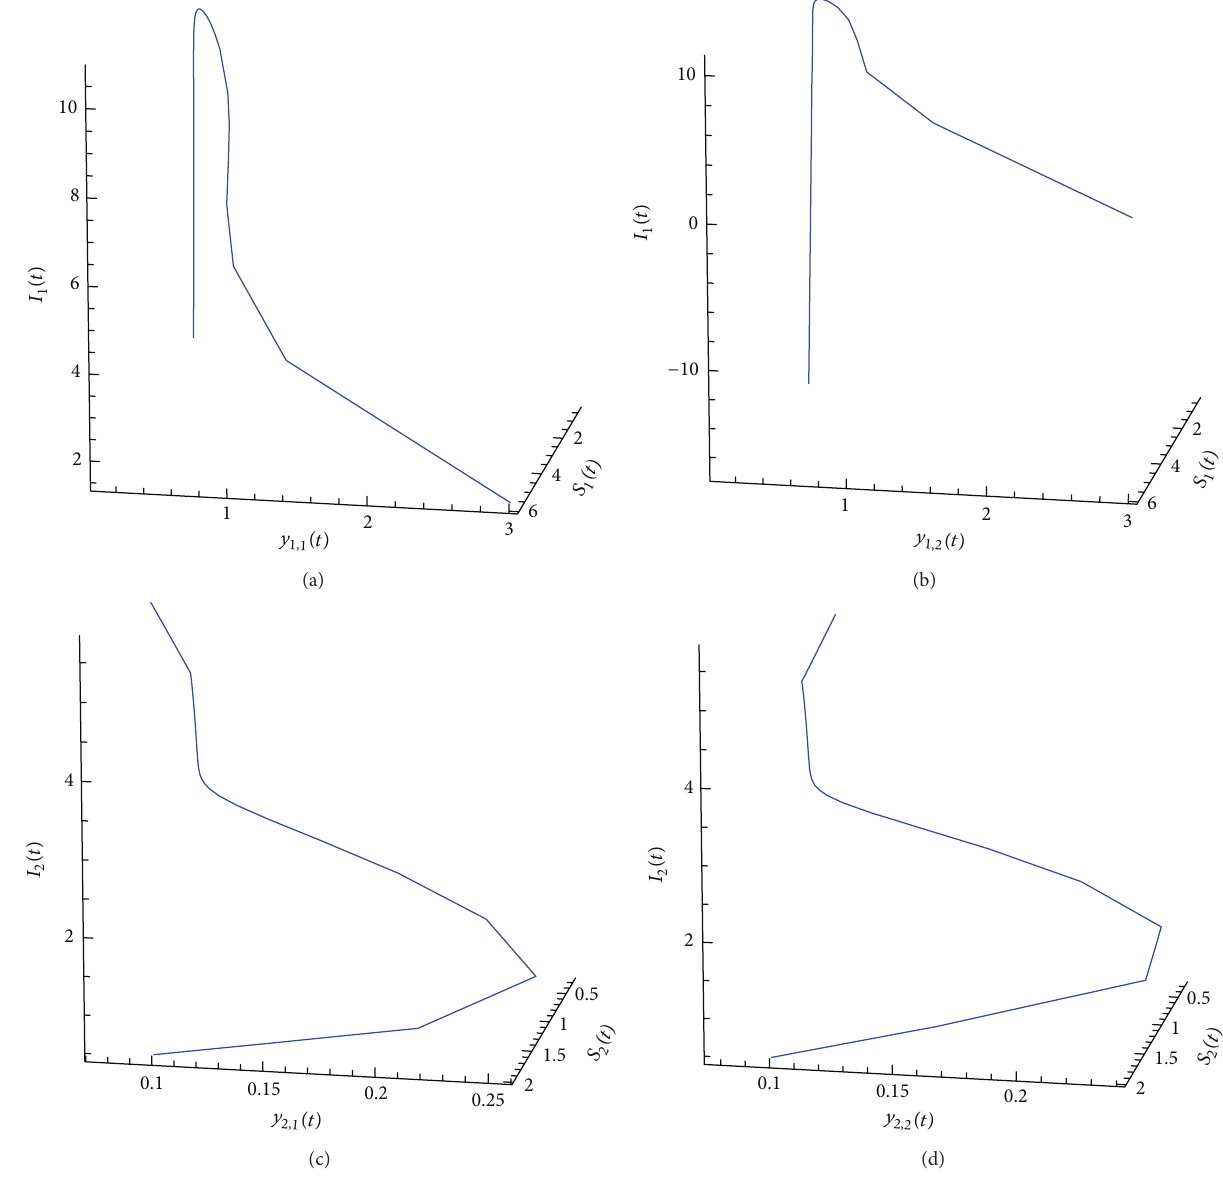
Figure 4: Numerical simulation of (45) with 𝑅 0 = 1.67355 > 1 ; hence 𝑃 ∗ = (0.347644, 0.0760948, 0.0760948, 4.51674, 0.330353, 0.0765909, 0.0765909, 4.4678) is globally stable. Graphs (a) and (b) illustrate that 𝑆 1 (𝑡),𝑦 1,1 (𝑡),𝑦 1,2 (𝑡) , and 𝐼 1 (𝑡) will eventually towards to steady state. Graphs (c) and (d) illustrate that 𝑆 2 (𝑡),𝑦 2,1 (𝑡),𝑦 2,2 (𝑡) , and 𝐼 2 (𝑡) will eventually towards to steady state. Initial values are 𝑆 1 (0) = 6, 𝑆 2 (0) = (0) = 3, 𝑦 (0) = 3, 𝑦 (0) = 0.1, 𝑦 (0) = 0.1, 𝐼 (0) = 1.5 , and 𝐼 (0) = 0.5 2, 𝑦 1,1 1,2 2,1 2,2 1 2